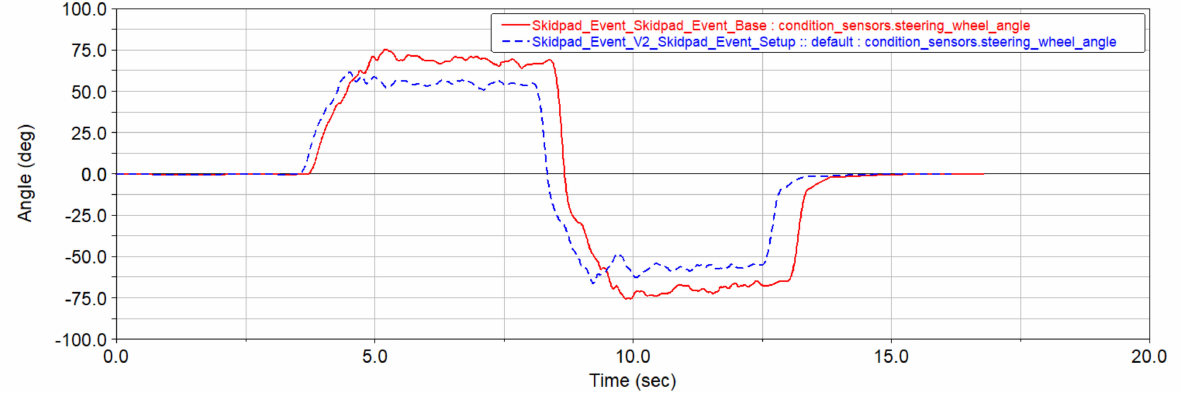
Figure 23. Skidpad Event-Steering wheel angle